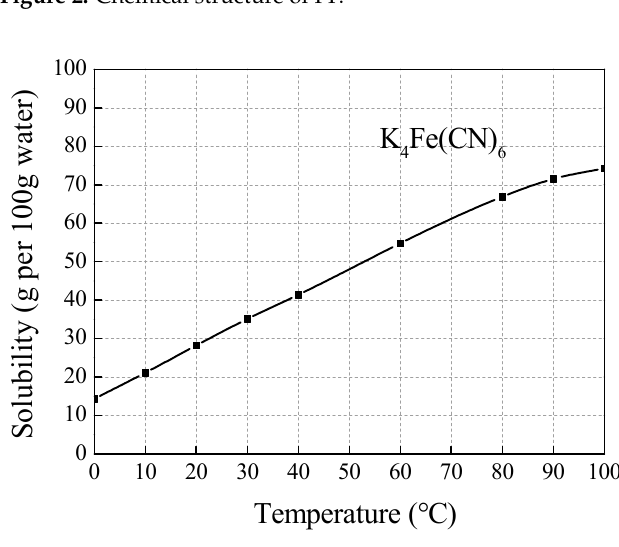
Figure 3. Solubility of PF vs. temperature [19] .